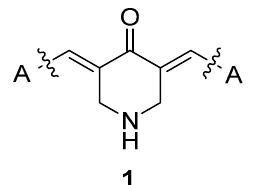
Figure 2. Curcumin analogue.